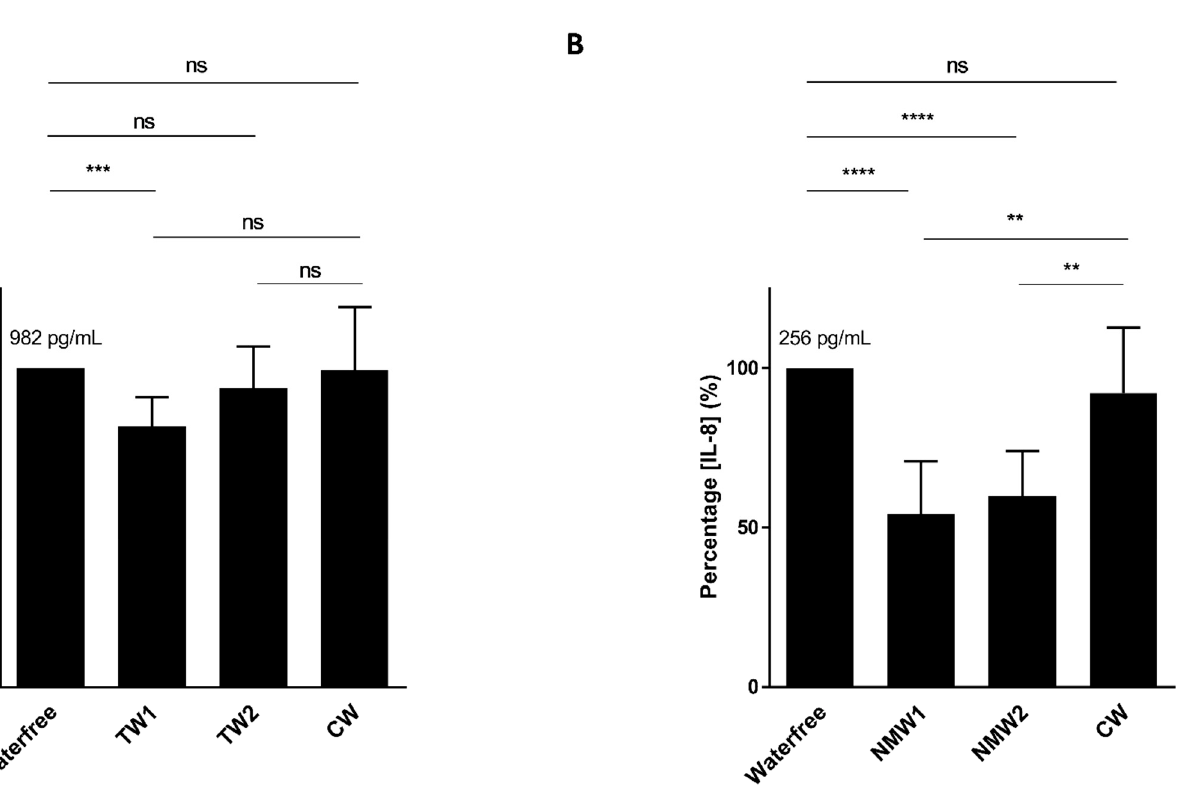
Figure 1. Secretion of the pro-inflammatory cytokine IL-8 by T84 cells after stimulation with an LF82 bacterial lysate ( A ) or exposure to H 2 O 2 ( B ) in the presence of 50 µL of different waters (distilled water or NMW1 or NMW2). The results are presented as the mean ± SEM of at least five independent experiments. Statistical comparisons were carried out by one-way ANOVA with the Bonferroni post hoc test (** p < 0.01, *** p < 0.001, **** p < 0.0001, ns – not significant) after normality testing using the Kolmogorov–Smirnov test.